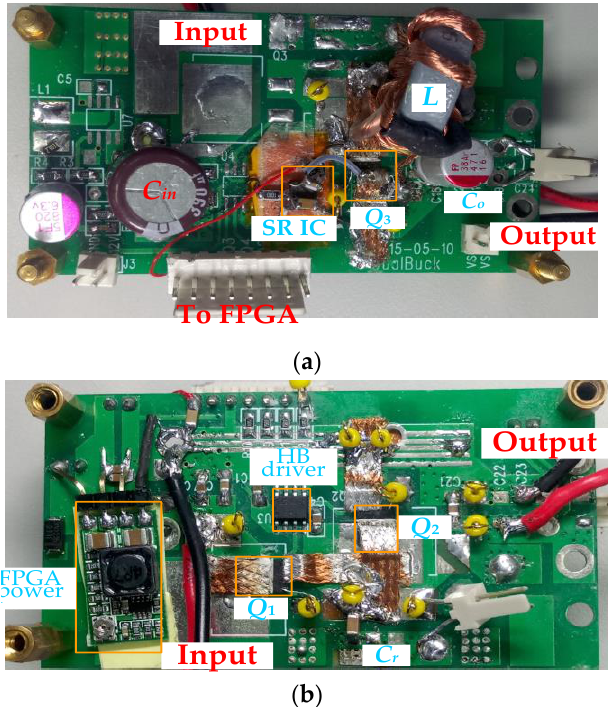
Figure 16. Measured transient waveforms of V o ripple, v Cr ripple, v CF , and i Cr : ( a ) from 50% to 100% load at 24 V input; ( b ) from 100% to 50% load at 24 V input; ( c ) from 50% to 100% load at 36 V input; ( d ) from 100% to 50% load at 36 V input; ( e ) from 50 to 100% load at 48 V input; and ( f ) From 100% to 50% load at 48 V input.